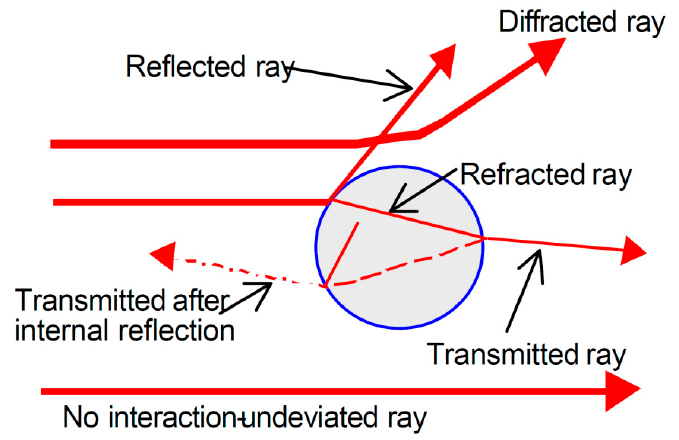
Figure 3. The potential interaction between a light beam and an isolated spherical particle. When the ray and the particle are far enough away, there is no interaction; interaction with the edge of the particle leads to diffraction. When the ray intersects the particle, other phenomena occur, such as refraction, reflection (both internal and external), and transmission. The interaction is considered conservative because there is no absorption (image reprinted with permission of the authors in [52], provided by Micromeritics Instrument Corp.).